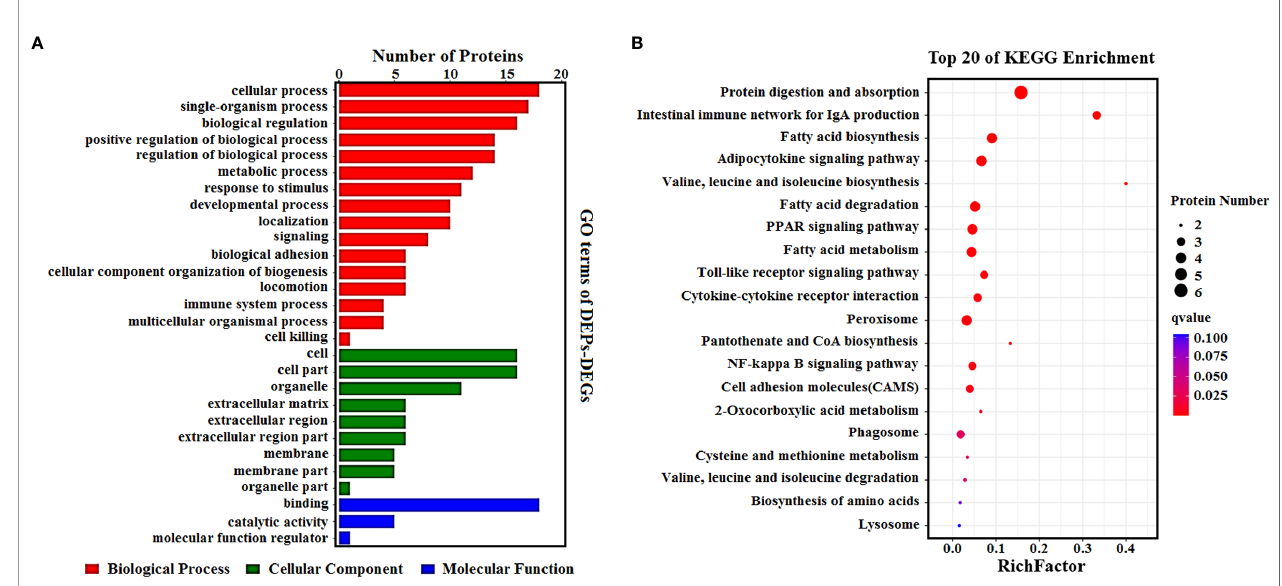
FIGURE 7 | (A) GO enrichment analysis for DEPs_DEGs. Different colors represent different types of GO terms; (B) KEGG pathway analysis for DEPs_DEGs. The top 20 signi fi cant enrichment pathways were